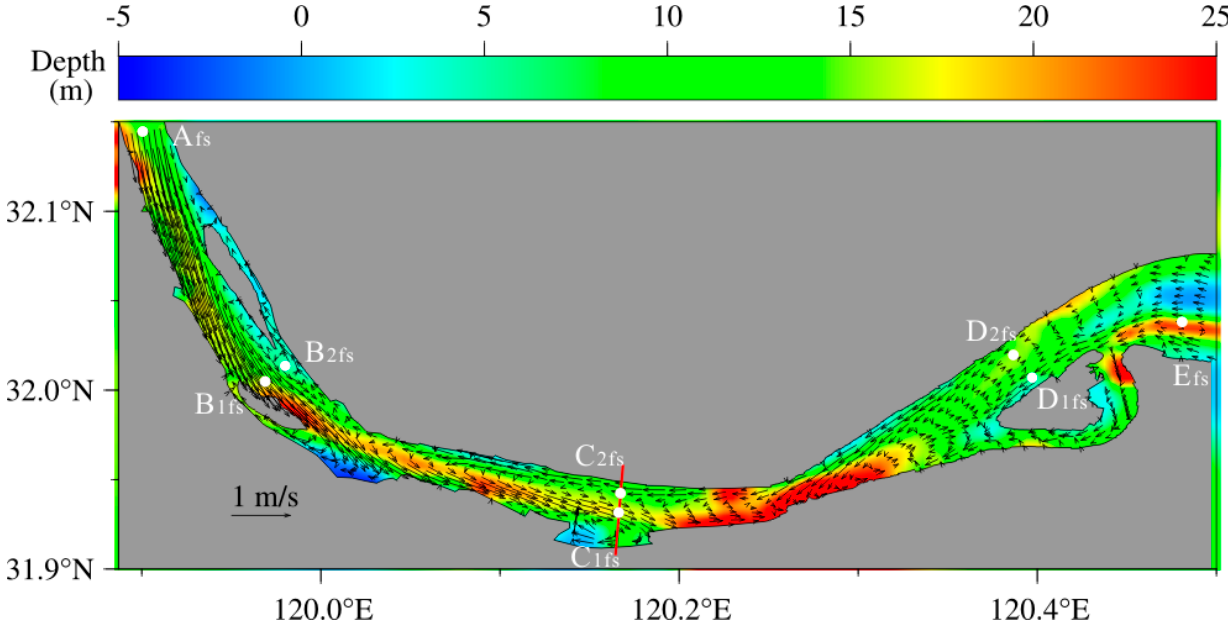
Figure 4. Instantaneous surface current field near Jiangyin in the case of river discharge of 48,161 m 3 /s. The red line represents the tidal current limit.